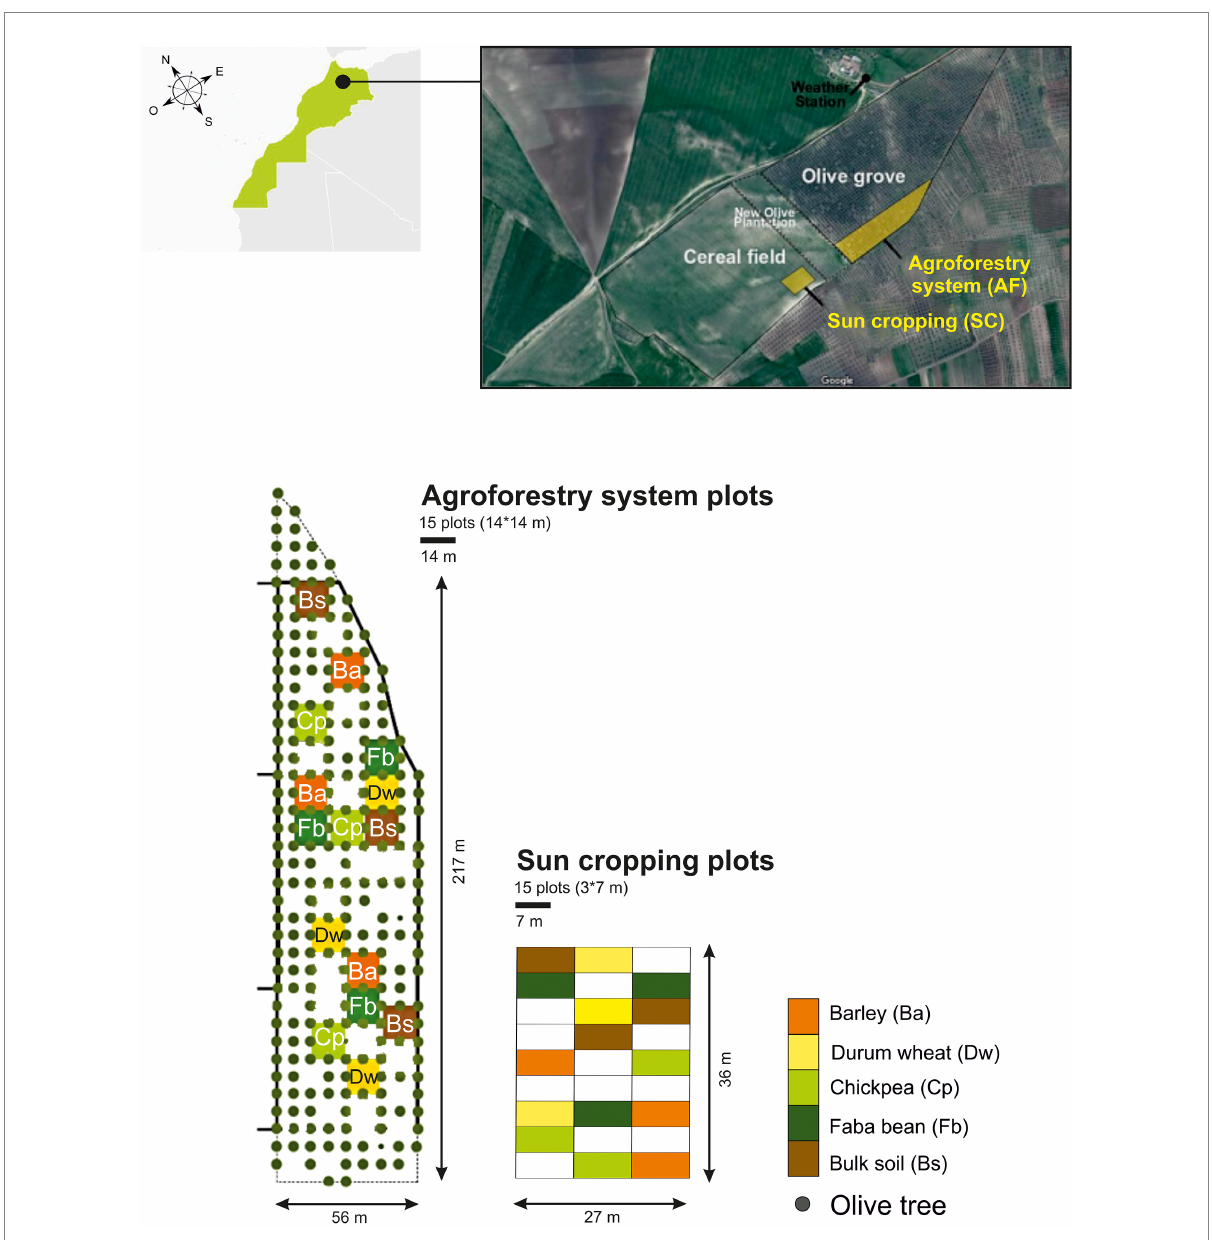
FIGURE 1 Schematic overview of the experimental design. AF, agroforestry system; SC, full sun cropping; Bs, bulk soil; Ba, barley; Dw, durum wheat; Cp, chickpea; Fb, Faba